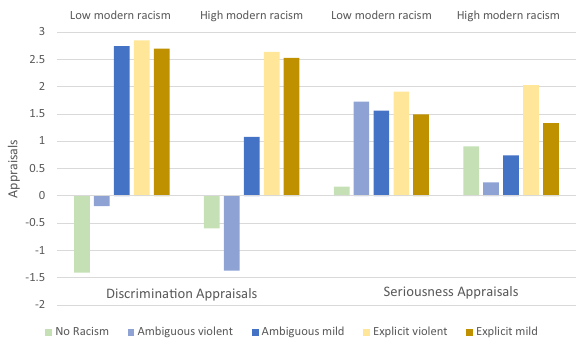
Fig. 7 Moderating effects of modern racist attitudes on Whites ’ appraisals of whether the video scenarios were discriminatory (left) and whether the events depicted seriously affected the target (right) as a function of racist cues presented in each of the fi ve conditions. Whites who expressed lower modern racism (1 SD below the mean) were more likely to perceive discrimination when it was explicit (irrespective of the presence of violence) or ambiguous and mild, and were more likely to perceive the events in all four racist conditions (relative to no racism) as having serious negative implications for the target. Whites who reported higher modern racism (1 SD above the mean) were less likely to appraise ambiguous events as constituting discrimination particularly when violence was involved, and uniquely perceived negative consequences as serious when events entailed explicit violent